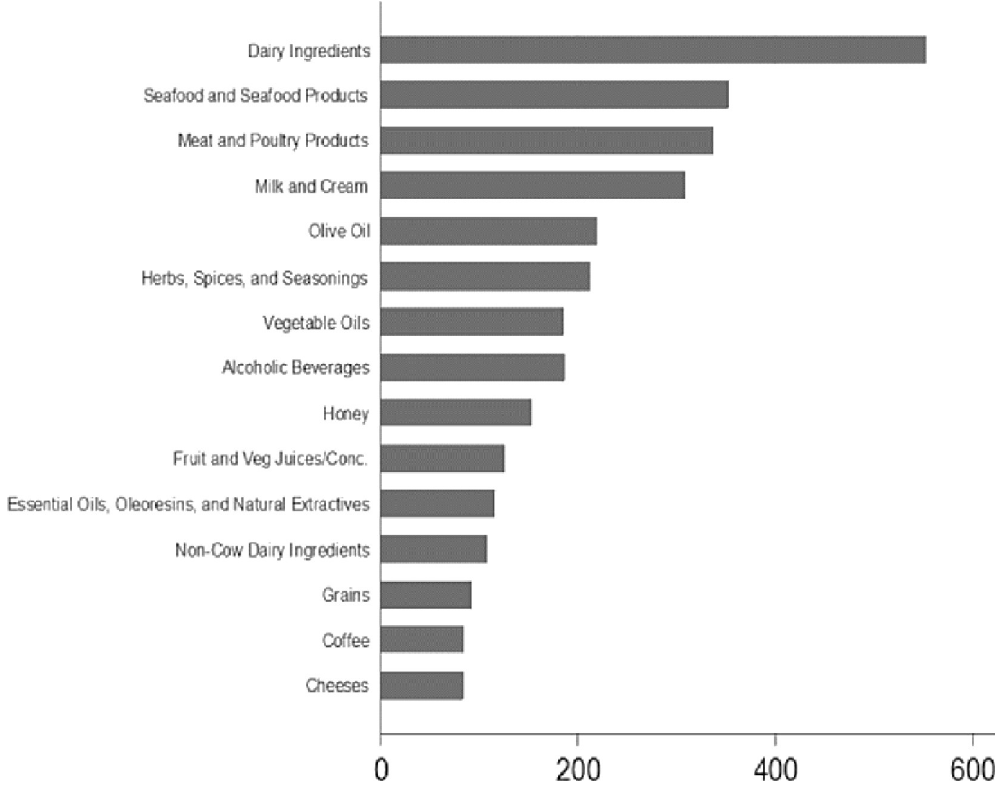
Fig 1. Commodities with the highest number of notifications in the global food fraud. Database Source: [16]; extracted from USP Food Fraud Database (https://decernis.com/solutions/food-fraud-database/).